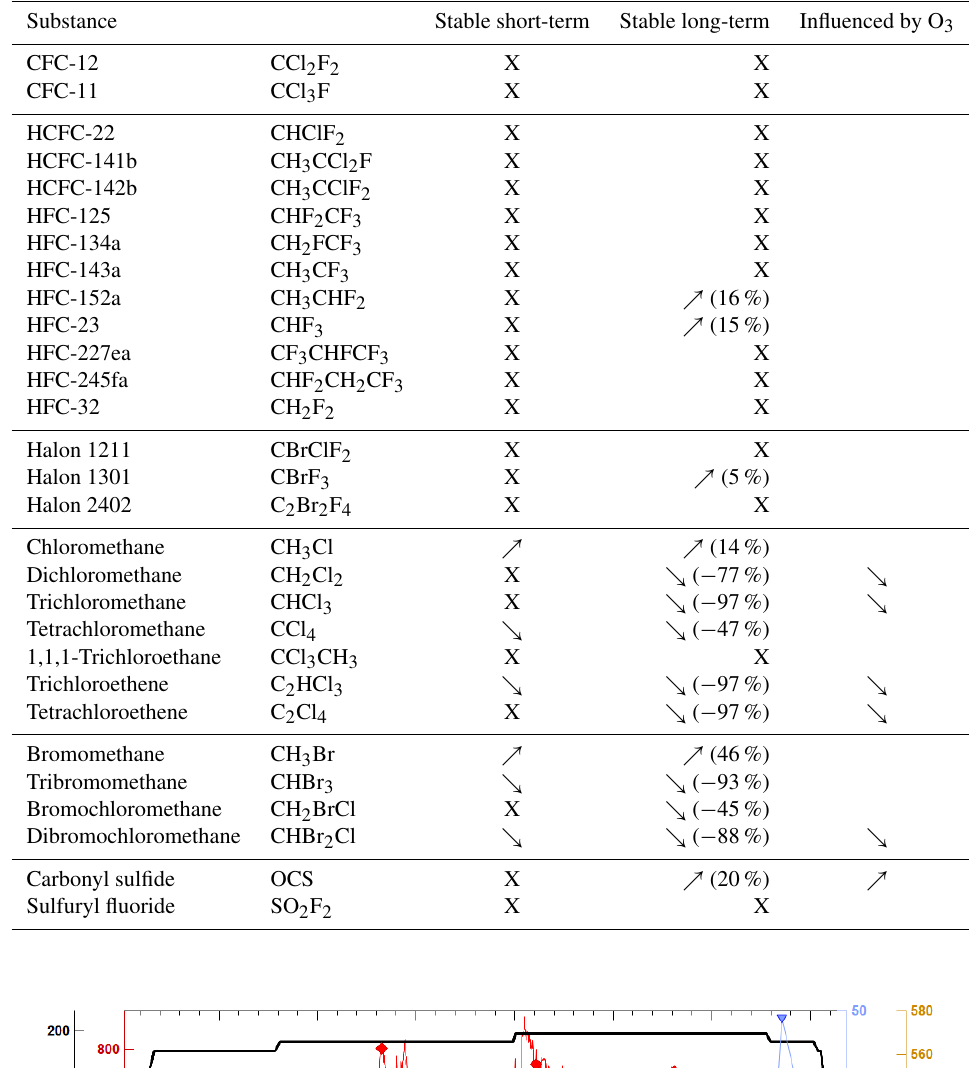
Table 1. Results of short-term (8d) storage test, long-term (57d) storage test, and ozone interference. “X” indicates that substances were found to be stable in the respective storage test, and arrows indicate whether mixing ratios were increasing ( (cid:37) ) or decreasing ( (cid:38) ). Numbers indicate the maximum deviation measured for substances not stable in HIRES cylinders.